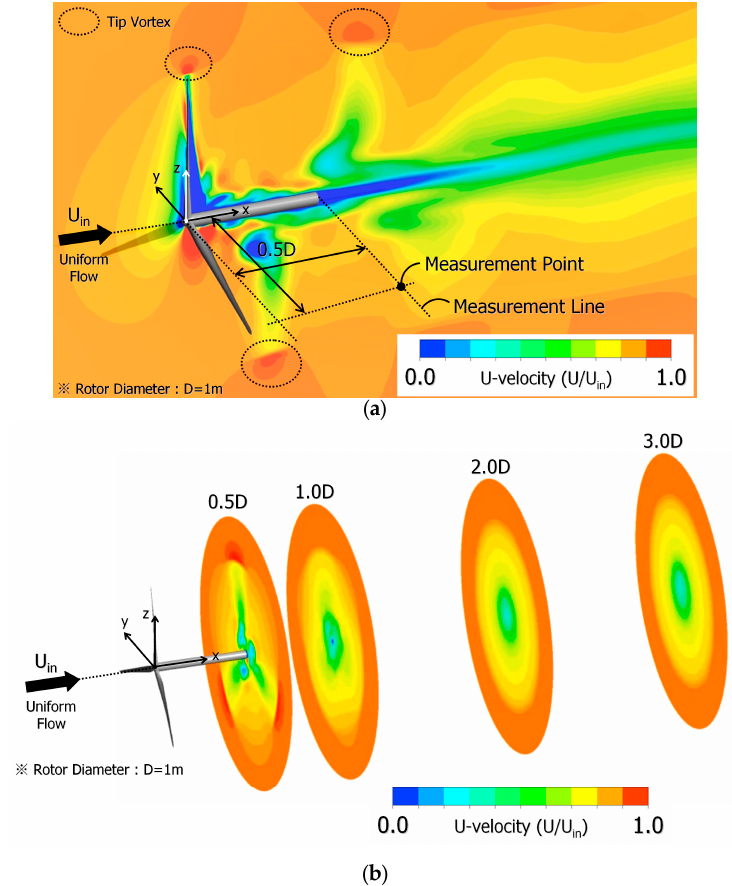
Figure 9. Simulation results for the 1/88 scale wind turbine model, the spatial distribution of instantaneous U-velocities, the standard grid, and the fully resolved geometries combined with unsteady RANS results produced by ANSYS(R) CFX(R). ( a ) x–z plane; ( b ) y–z plane.